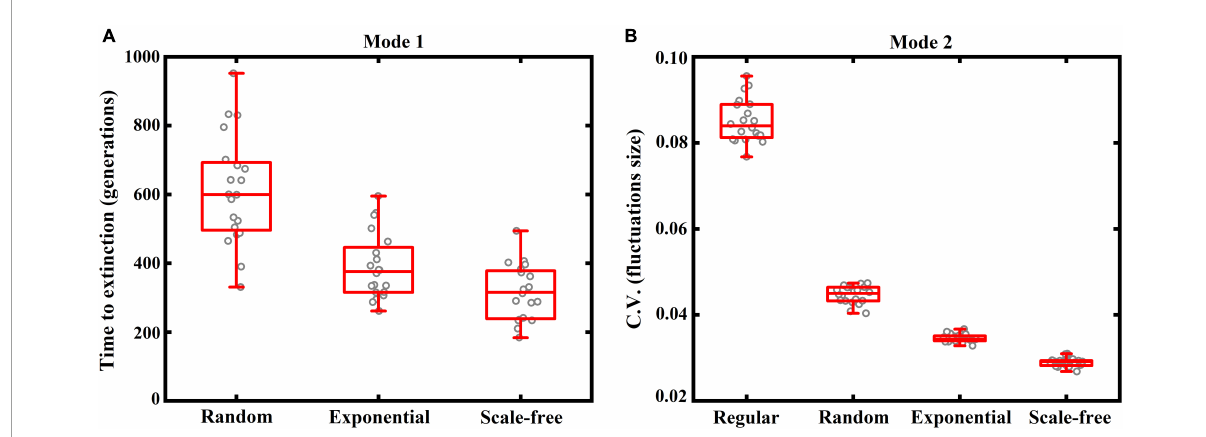
FIGURE3 Box plots (red) of ecosystem stability (with 20 replicates for each case, indicated by gray cycles), characterized by panel ( A : Mode 1) the time (generations) required for the first species to go extinct if stochastic extinctions occur, or ( B : Mode 2) coefficient of variation in fluctuations size (C.V. around the mean species abundances at steady state) if three species can coexist. Again, four typical network structures are included: lattice-structured regular, randomly connected, exponential and scale-free networks. Note that, under Mode 1, three species can coexist in the regular network (see Figure 2A ), which is thus absent in panel (A) . More time required for species extinction or lower values of C.V. implies more stable coexistence. Other settings are the same as in Figure 2 .